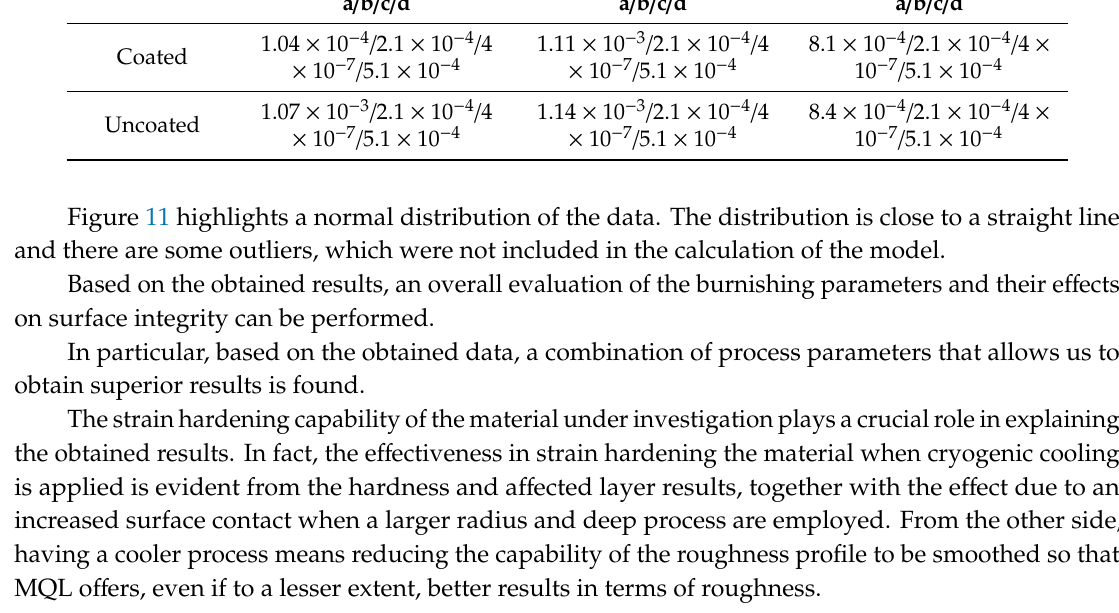
Table 6. Values for wear rate constants in varying lubro / cooling and coating conditions.